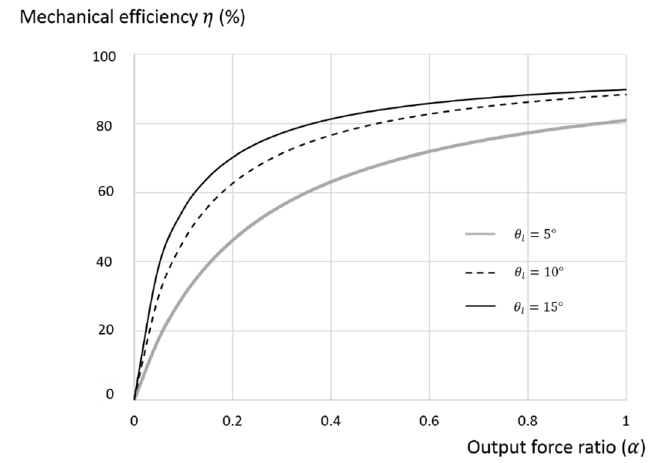
ffi ciencies with lead angles of 5, 10, and 15 Figure 6. The efficiencies with lead angles of 5, 10, and 15 degrees. Figure 6. The e Figure 6. The efficiencies with lead angles of 5, 10, and 15 degrees.